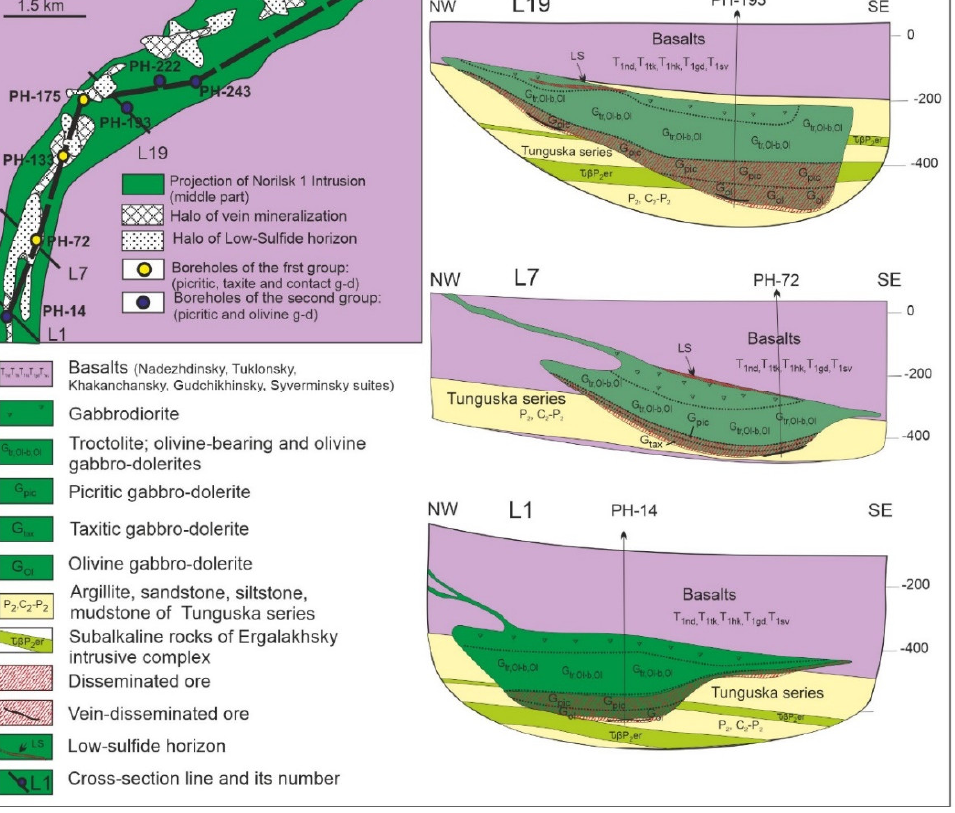
Figure 2. Location of boreholes within the study area (the middle part of the Norilsk 1 intrusion) according to Novageo LLC, and cross-sections along the exploration lines.